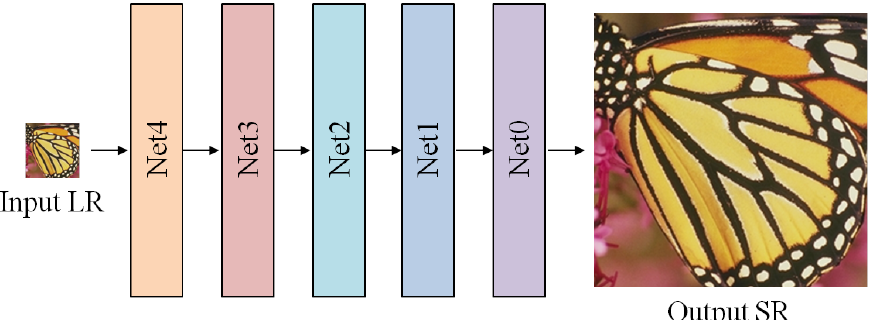
Figure 6. Cascaded network structure of different